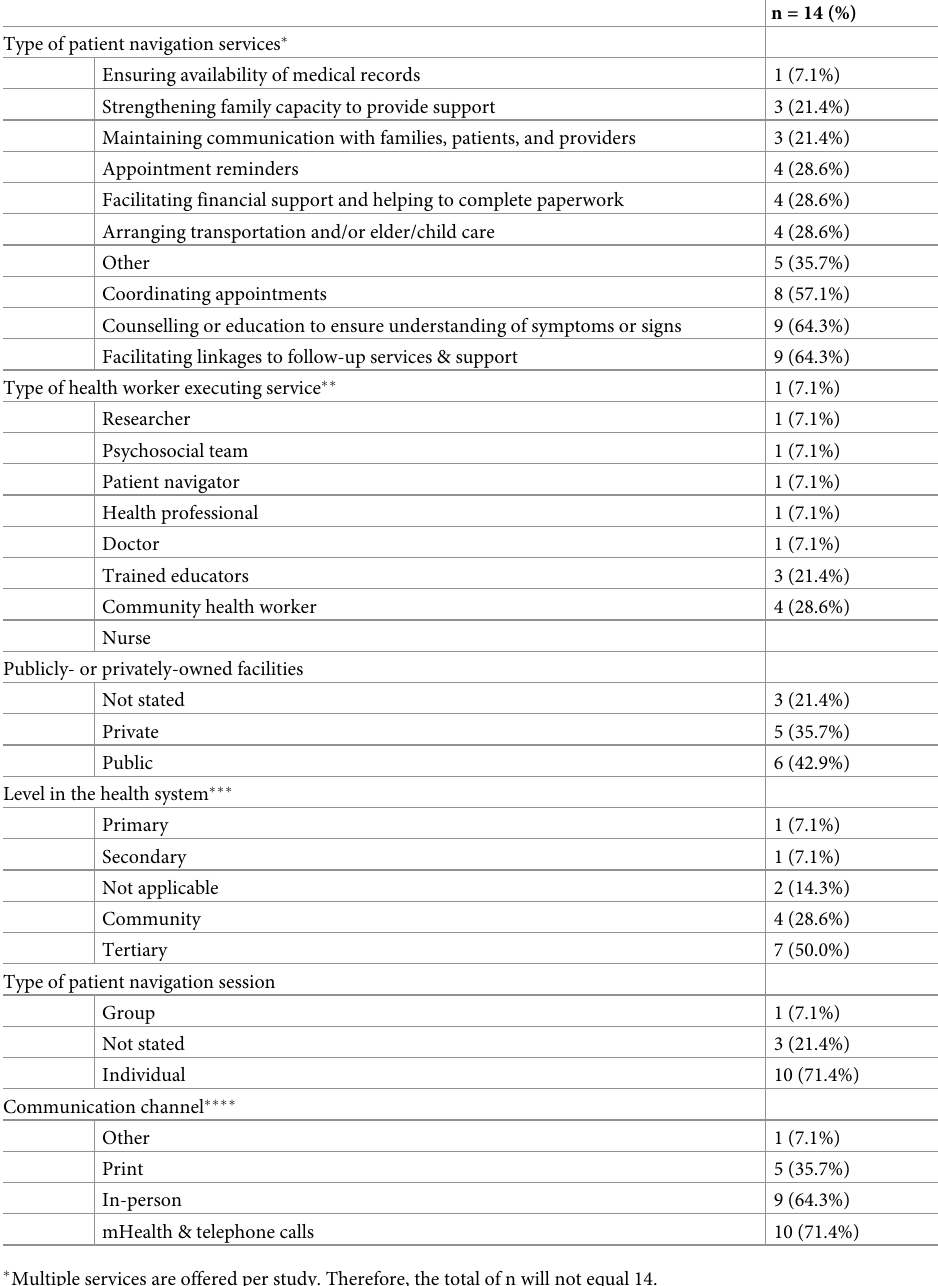
Table 3. Characteristics of patient navigation